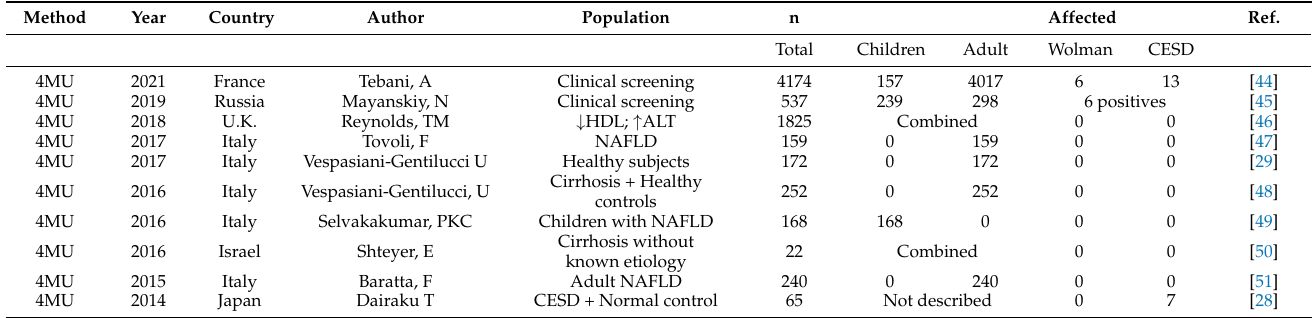
Table 3. High-risk screening for LAL-D enzyme using